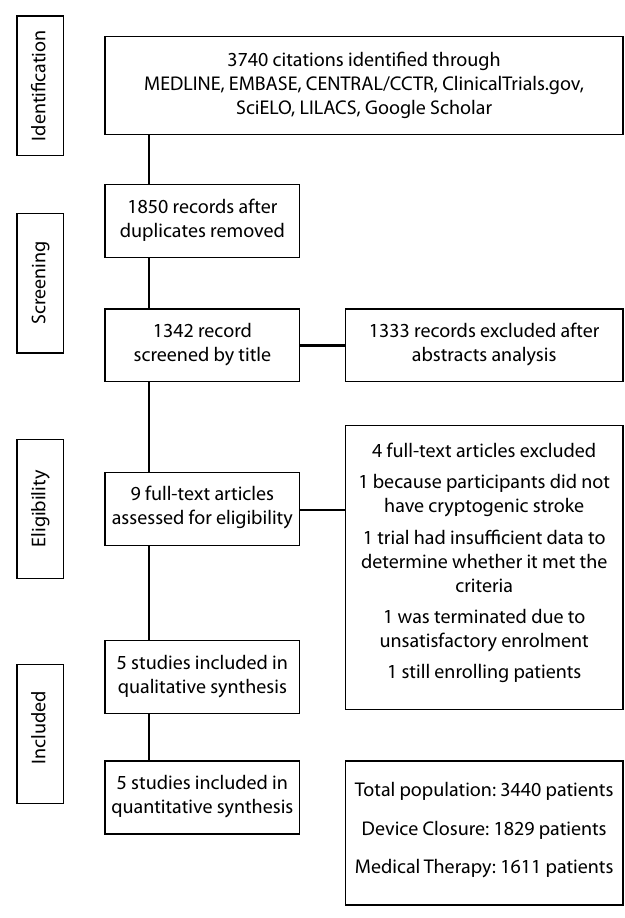
Fig. 1 – Flow diagram of studies included in data search. CENTRAL/CCTR=Cochrane Central Register of Controlled Trials; LILACS=Latin American and Caribbean Health Sciences